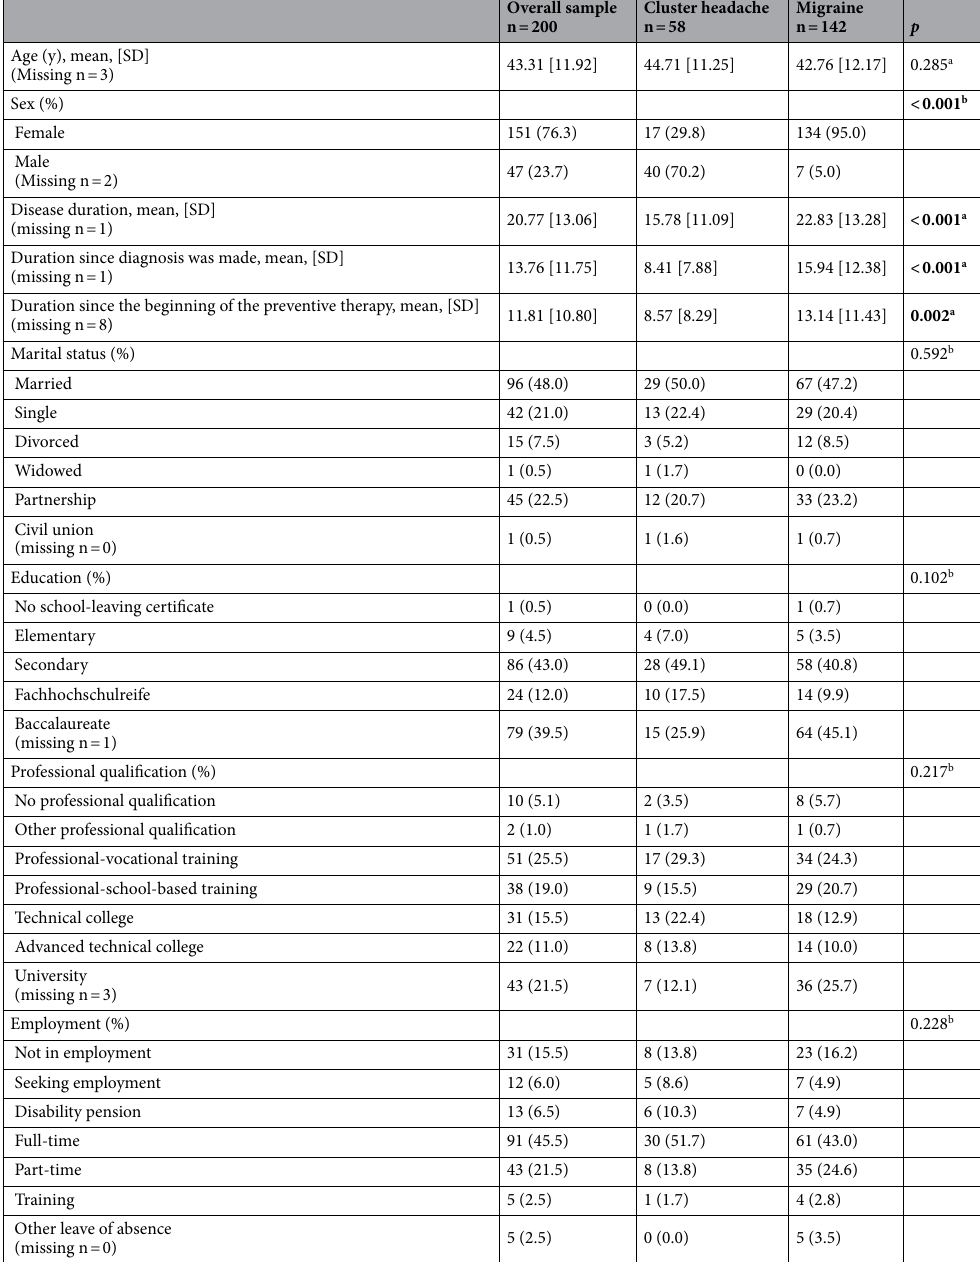
Table 1. Demographics and characteristics of the sample. a Welch test, b Pearson’s chi-squared test. Significant values are in